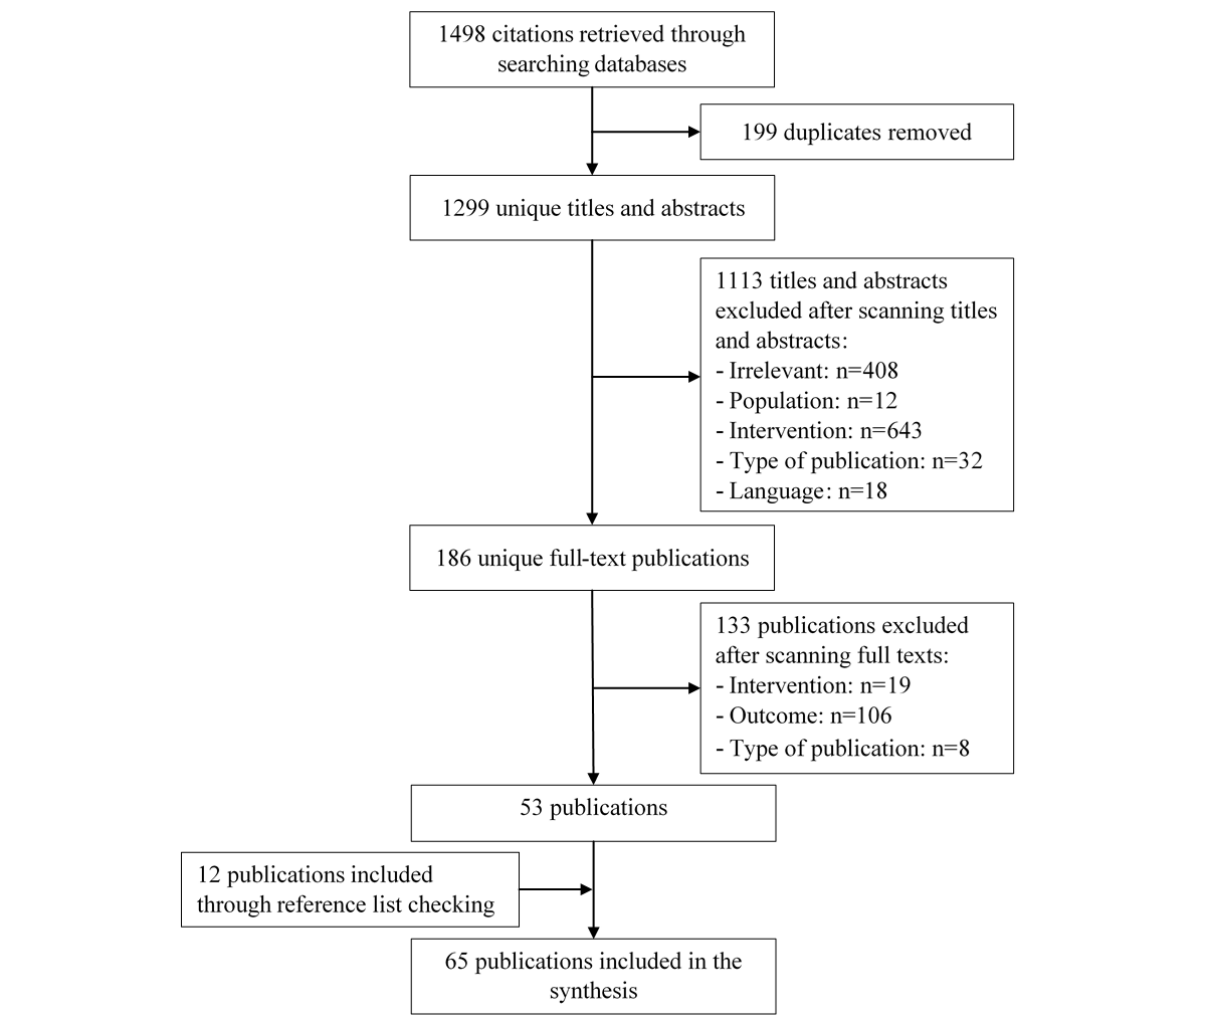
Figure 1. Flowchart of the study selection